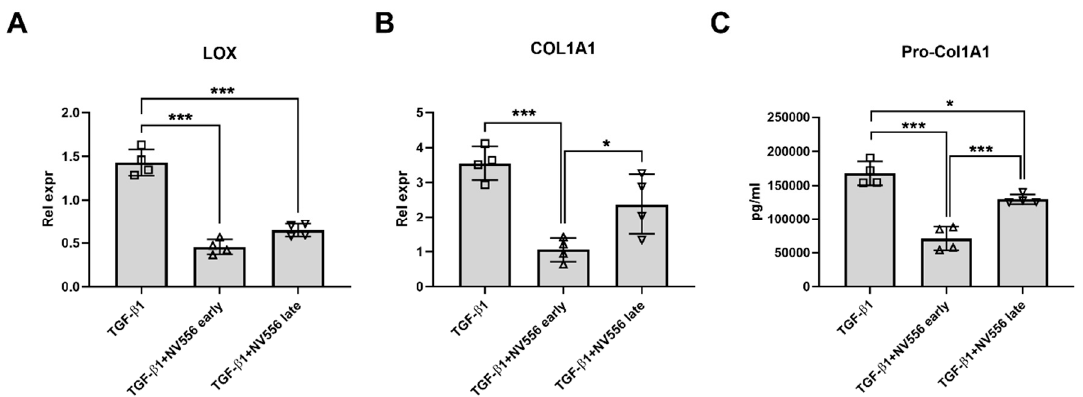
Figure 4. NV556 effect on gene expression ( A , B ) and procollagen secretion ( C ) in a 3D human liver model reseeded with LX2 cells. Data in A and B are represented as mean of relative expression over nontreated control cells ± SD and Data in A – C are statistically analyzed by one-way ANOVA, followed by Tukey’s multiple comparison test. * p < 0.05, ** p < 0.01 and *** p < 0.001, n = 4 scaffolds per condition investigated.